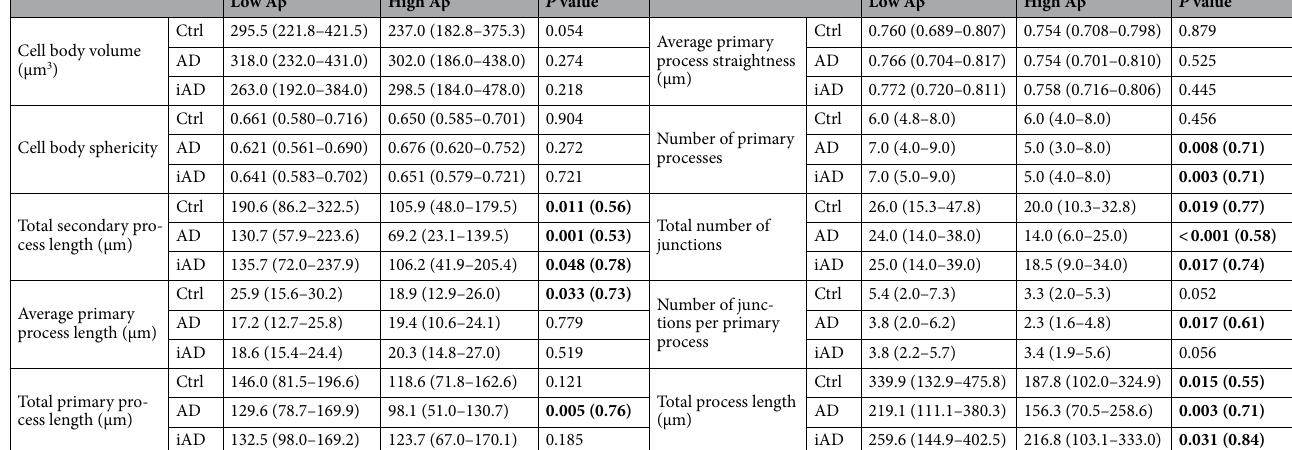
Table 4. Comparison of morphological features between low and high Aβ cases. Values are median with IQR. P value by the independent samples Mann–Whitney U test (low Aβ vs high Aβ within each group). Significant P values in bold with fold change (high Aβ with respect to low Aβ) between brackets. Ctrl Control